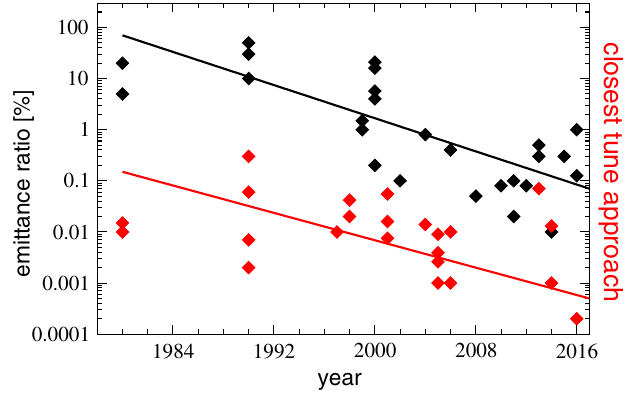
FIG. 2. Coupling evolution versus time for many circular accelerators as found in the bibliography of this paper. The closest tune approach in hadron machines and the emittance ratio ϵ = ϵ y x in lepton rings are used as figures of merit for the